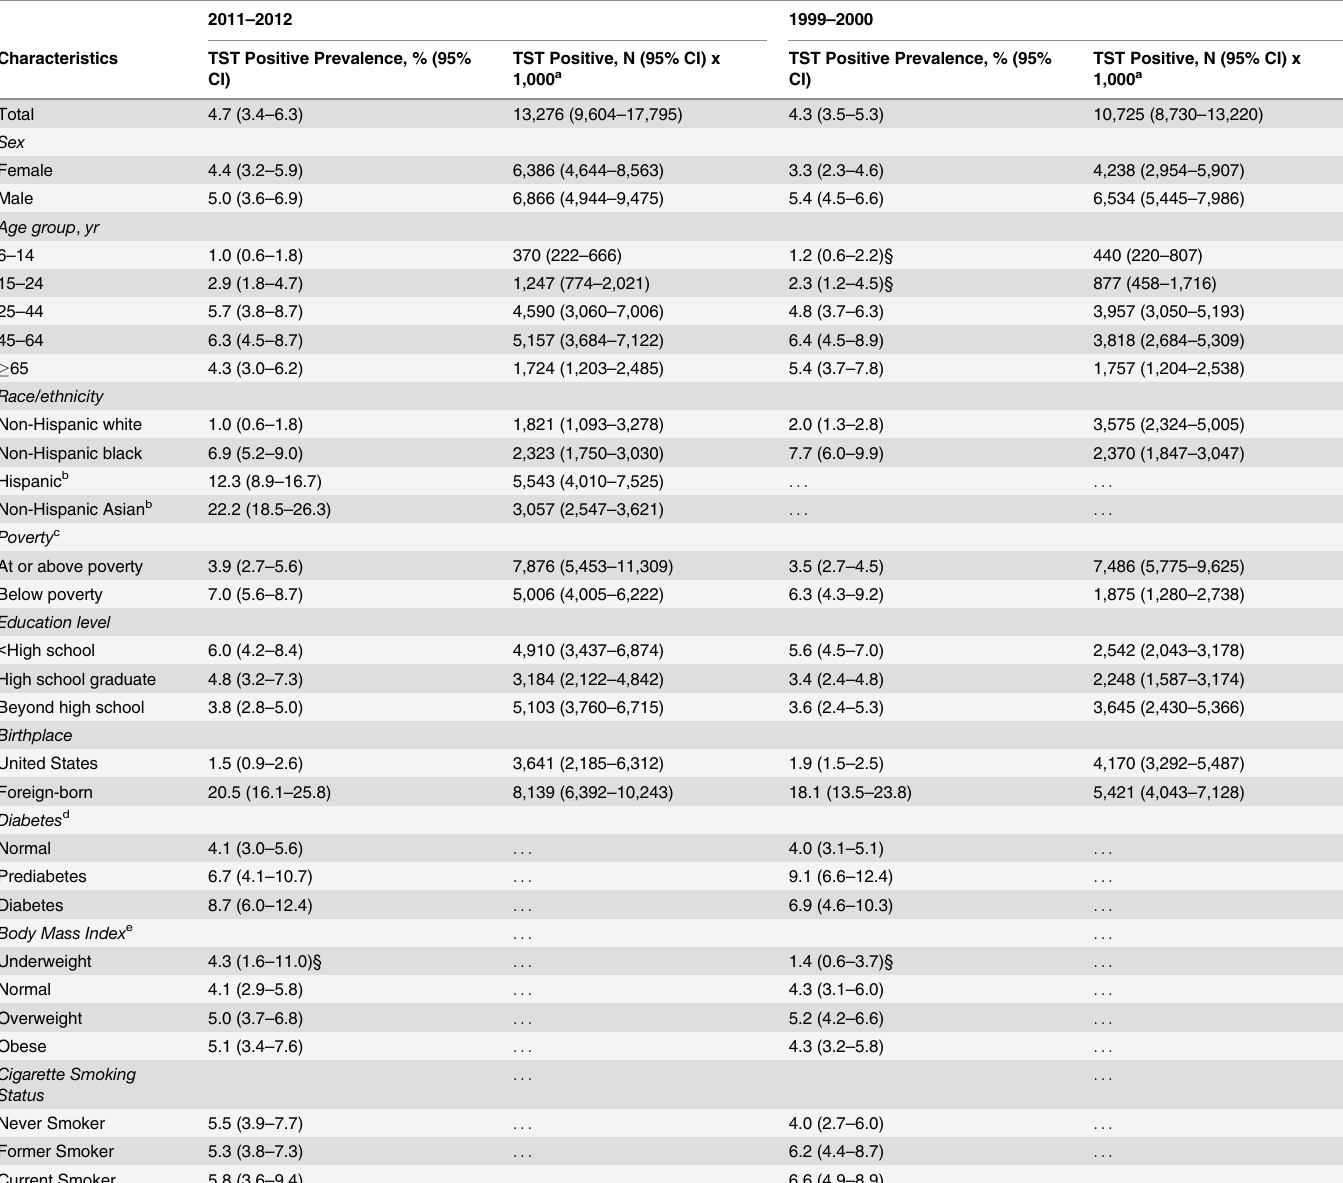
Table 1. Tuberculin Skin Test Positive Prevalence in the Civilian, Noninstitutionalized U.S. Population, Ages 6+, 2011 – 2012 and 1999 –